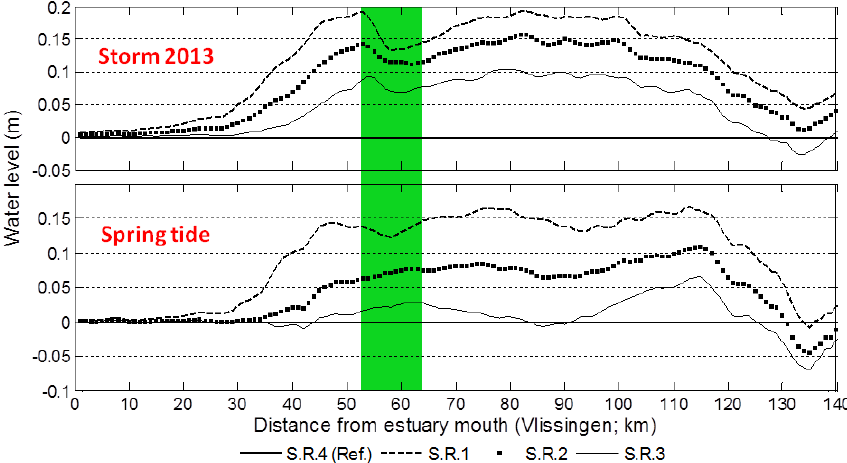
Figure 8. Scenarios for different realistic surface areas relative to reference scenario S.R.4. Scenarios given for a spring tide and storm tide (2013). The green area in the figure shows the location of the Saeftinghe wetland in the